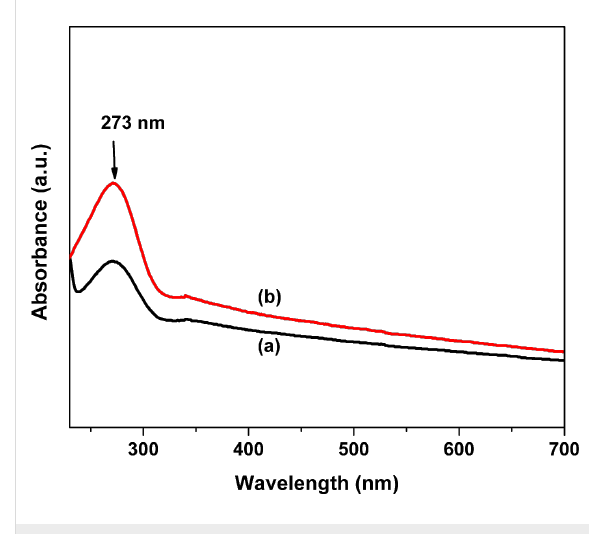
Figure 6: UV–vis spectra of (a) ZrO 2 and (b) Pt(1%)-ZrO 2 .